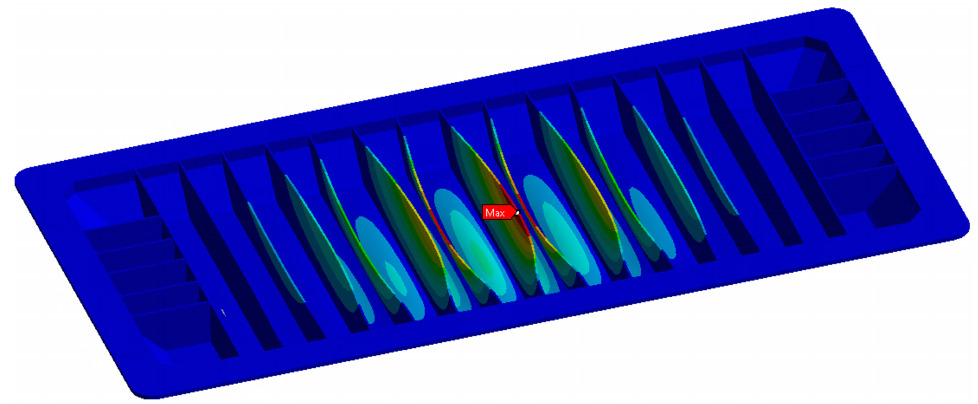
Figure 5. First buckling mode of the